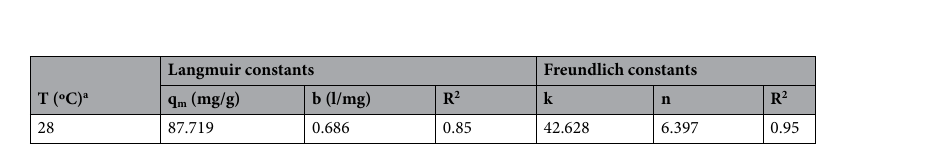
Table 7. Adsorption isotherm parameters for Sr(II) biosorption on Mg-treated sargassum sp. a Has no effect on optimization